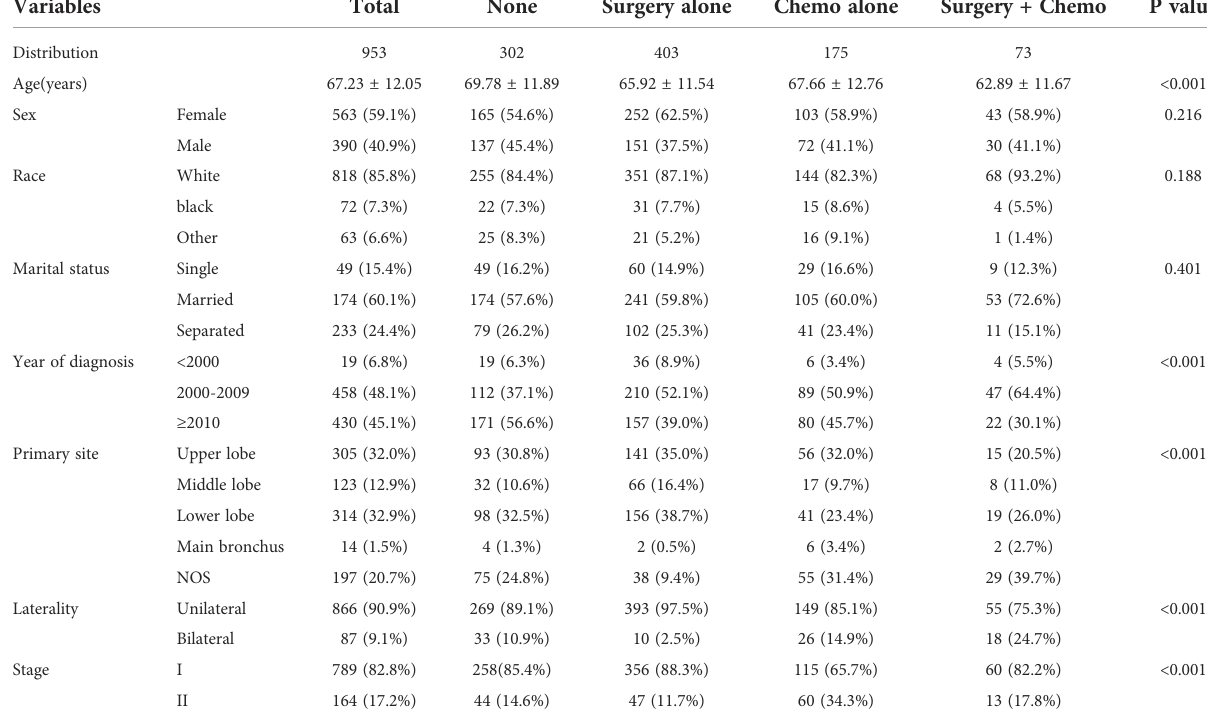
TABLE 1 Characteristics of primary pulmonary MALT lymphoma among the four